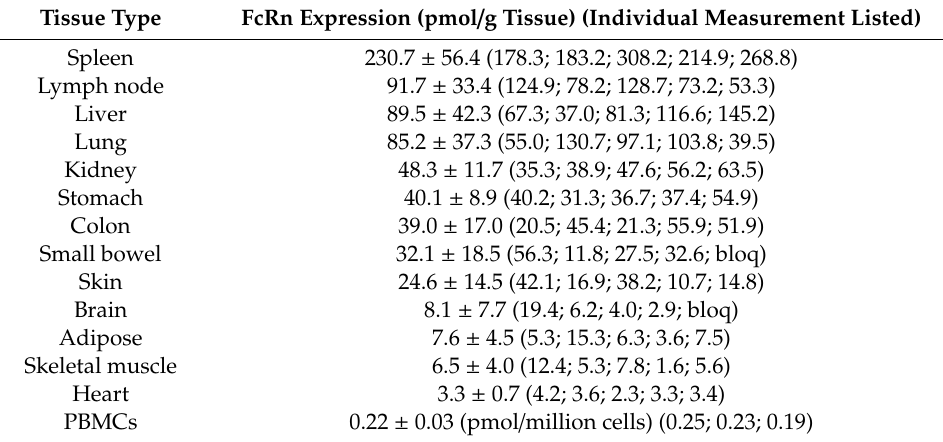
Bloq: below limit of quantification (below 0.89 pmol / g